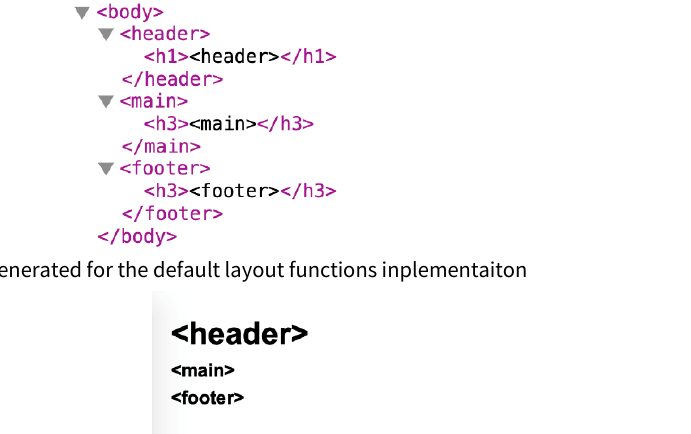
Figure 5. Visualization of the HTML code generated by the default layout functions